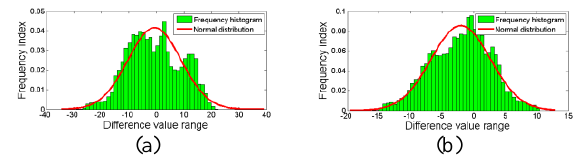
Figure 7. Frequency histogram of difference values between Contour-DEM and UAV-DEMs, georeferenced by (a) POS and (b) by